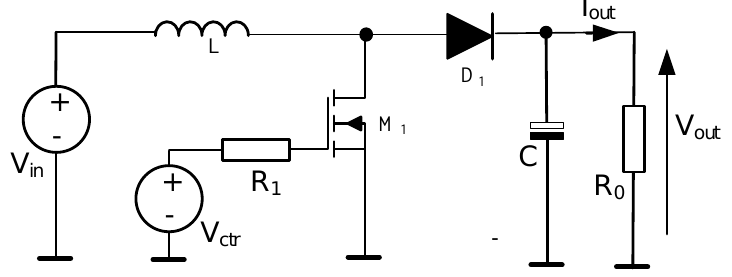
Figure 5. Diagram of the investigated boost converter.